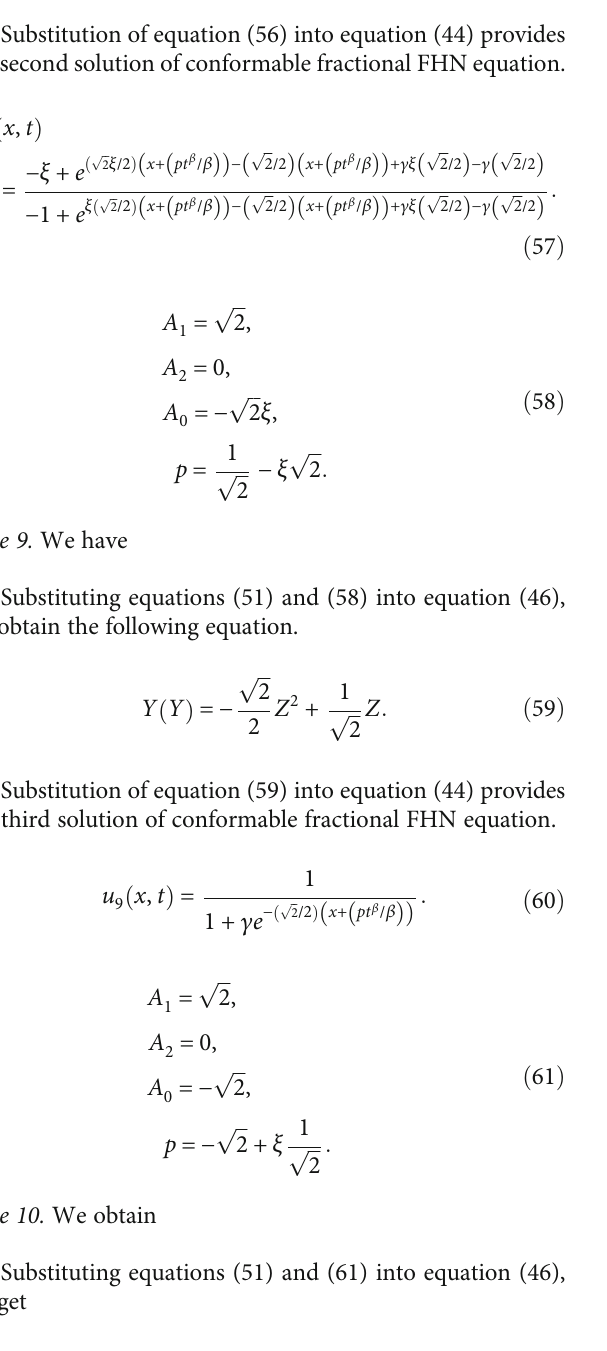
Figure 4. For smaller value of β , solutions attain more height which is depicted in Figure